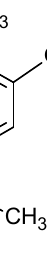
THY CAR Scheme 1. Chemical structures of thymol and Scheme 1. Chemical structures of thymol and carvacrol.